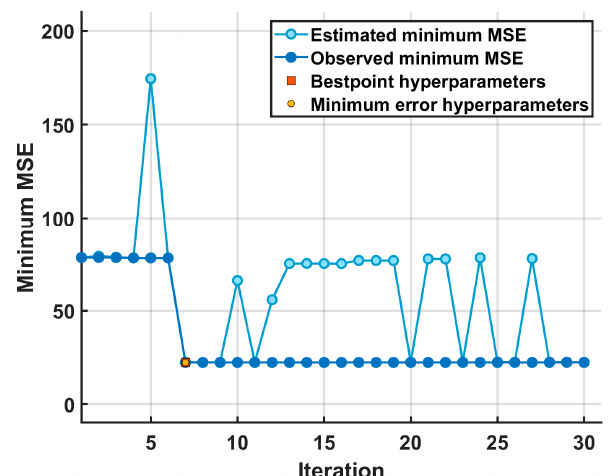
Figure 4. MSE optimization plot of the SVM model.